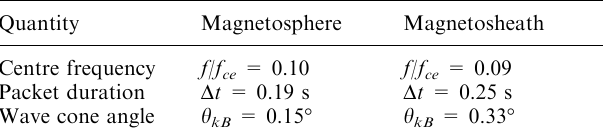
Table 1. Average frequency, wave packet duration, and wave cone angle for magnetospheric and magnetosheath electron whistlers Quantity Magnetosphere Magnetosheath Centre